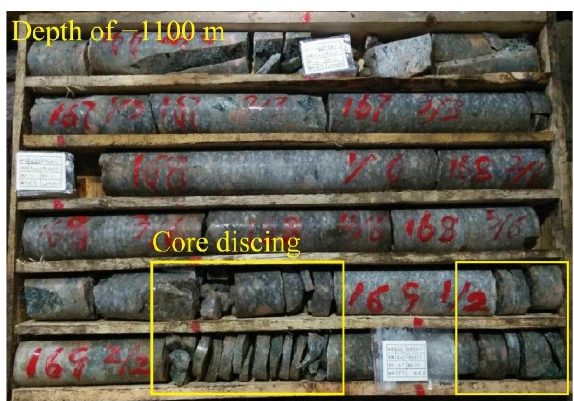
Figure 9. Core discing phenomenon.